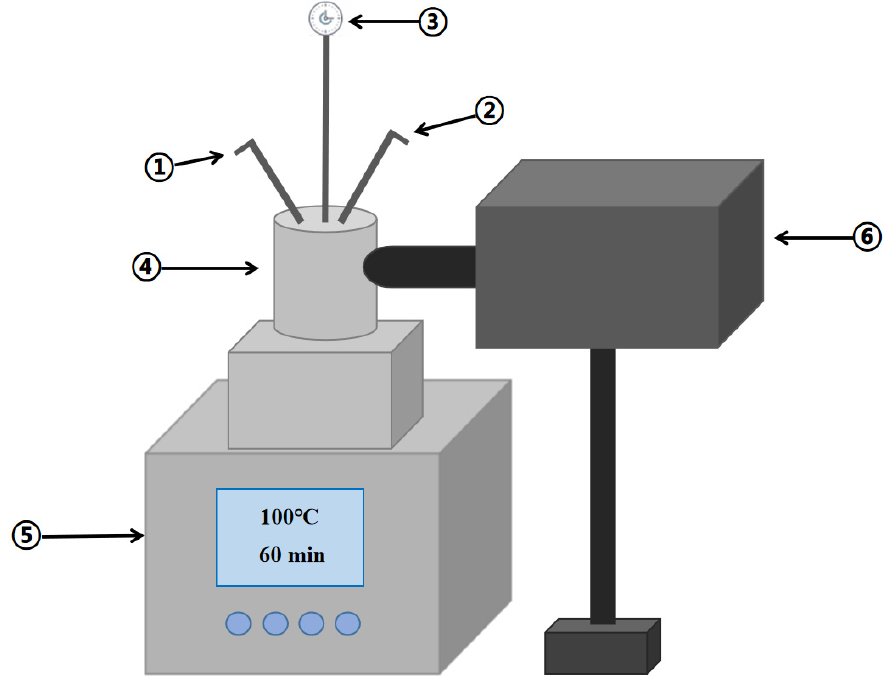
Figure 1. Schematic diagram of the laboratory UV-CWPO system. ( ① Intake valve, ② Exhaust valve, ③ Pressure gauge, ④ Photochemical high pressure reactor, ⑤ MRSC-TFM control system, ⑥ 30W UV-deuterium lamp source) .